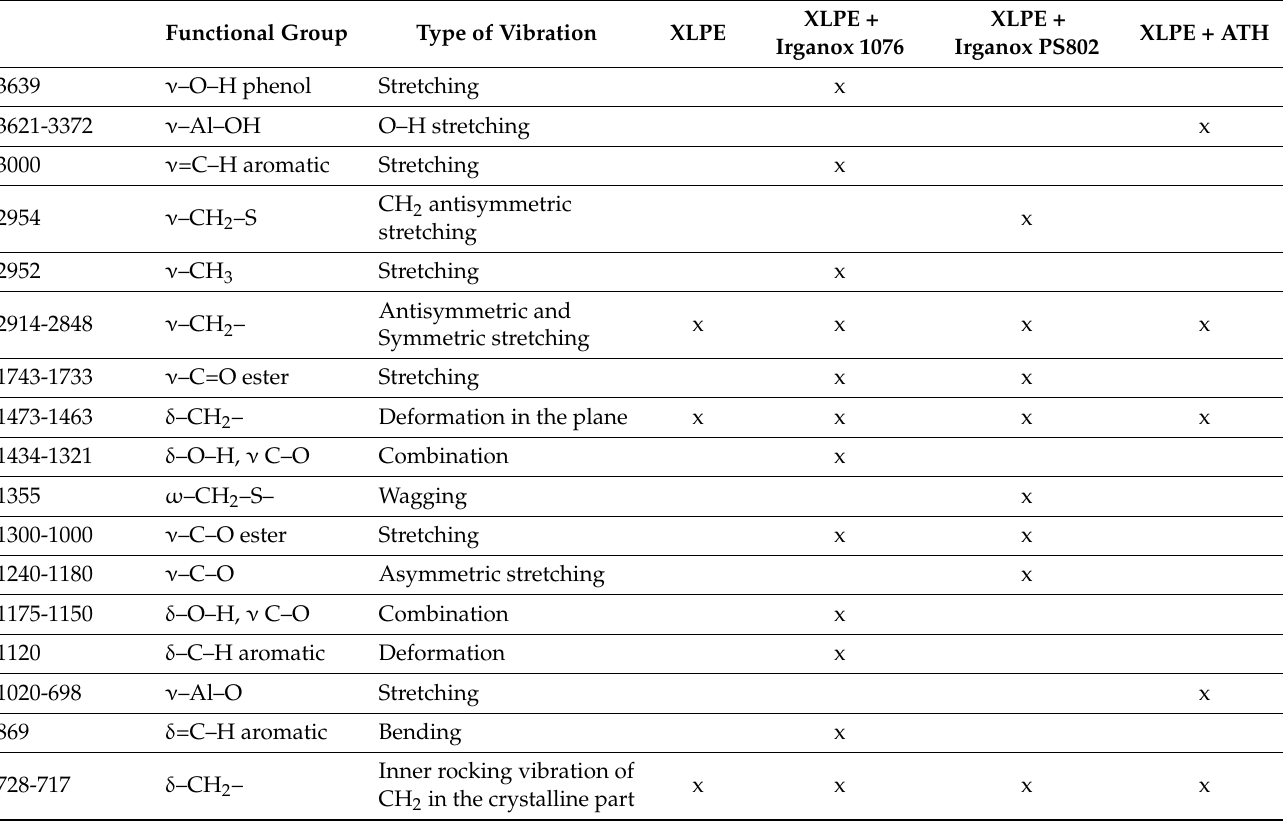
Table 2. Identification of the main FTIR bands of the unaged